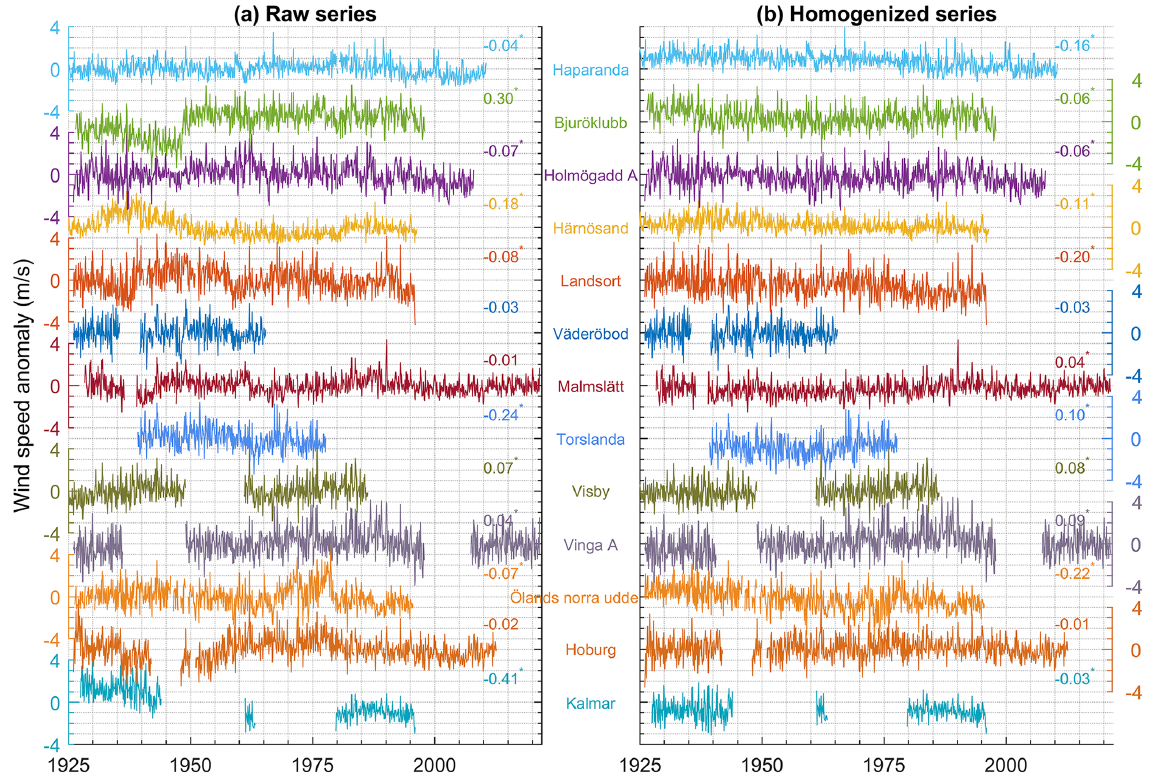
Figure 5. Comparison of (a) raw and (b) homogenized wind speed anomaly series rescued at the 13 stations in Sweden. The long-term trends (in ms − 1 per decade) are shown on the right, with ∗ indicating a significance level of